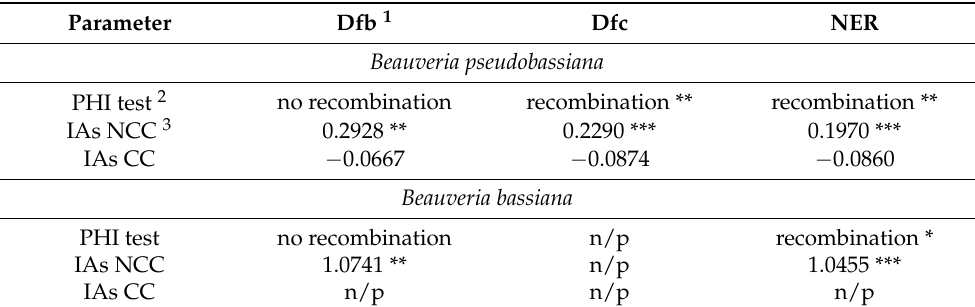
Table 2. Estimates of recombination of Beauveria bassiana and B. pseudobassiana . Estimates for B. caledonica were not possible due to insufficient informative